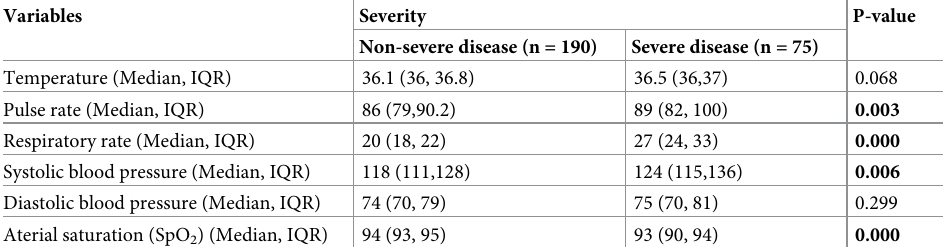
Table 2. Admission vital signs profile of study